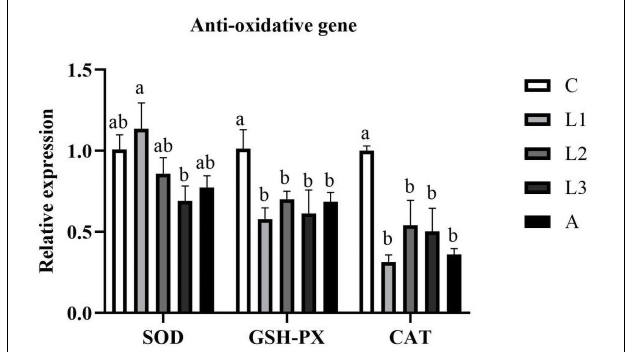
FIGURE 3 | Hepatopancreas RNA expression level of apoptosis genes of L. vannamei fed diet supplementation with/without lutein or astaxanthin for 56